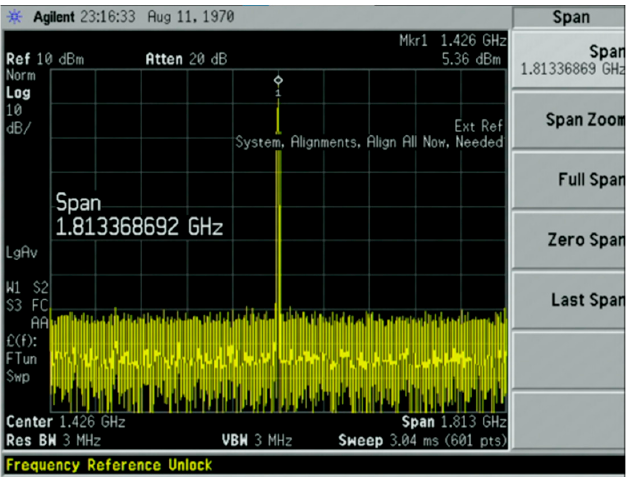
Figure 9. The output signal’s frequency spectrum.